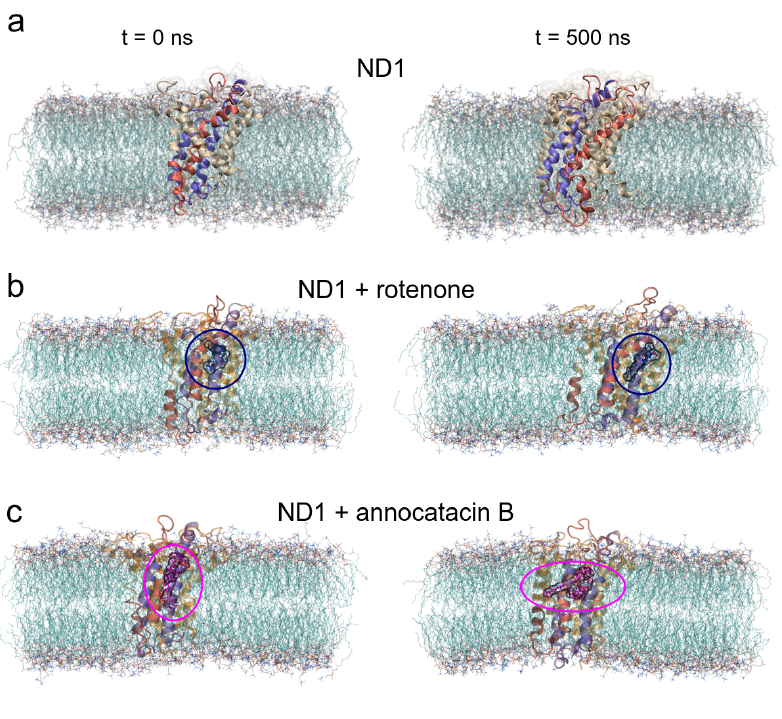
Figure 4. Overall structural organization of ND1 protein and its ligands in a membrane-embedded condition. The left panel shows the molecular complexes at initial conditions (0 ns). The right panel shows the complexes at 500 ns. ( a ) ND1 + DPPC membrane, ( b ) ND1 + DPCC + rotenone, and ( c ) ND1 + DPPC + annocatacin